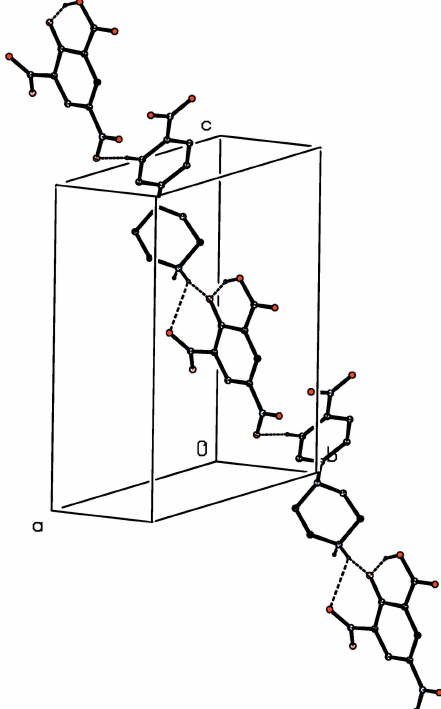
Figure 6 Part of the crystal structure of compound (II) showing the formation of a chain of hydrogen-bonded rings running parallel to the [101] direction. Hydrogen bonds are drawn as dashed lines and, for the sake of clarity, the H atoms bonded to those C atoms that are not involved in the motif shown have been omitted.